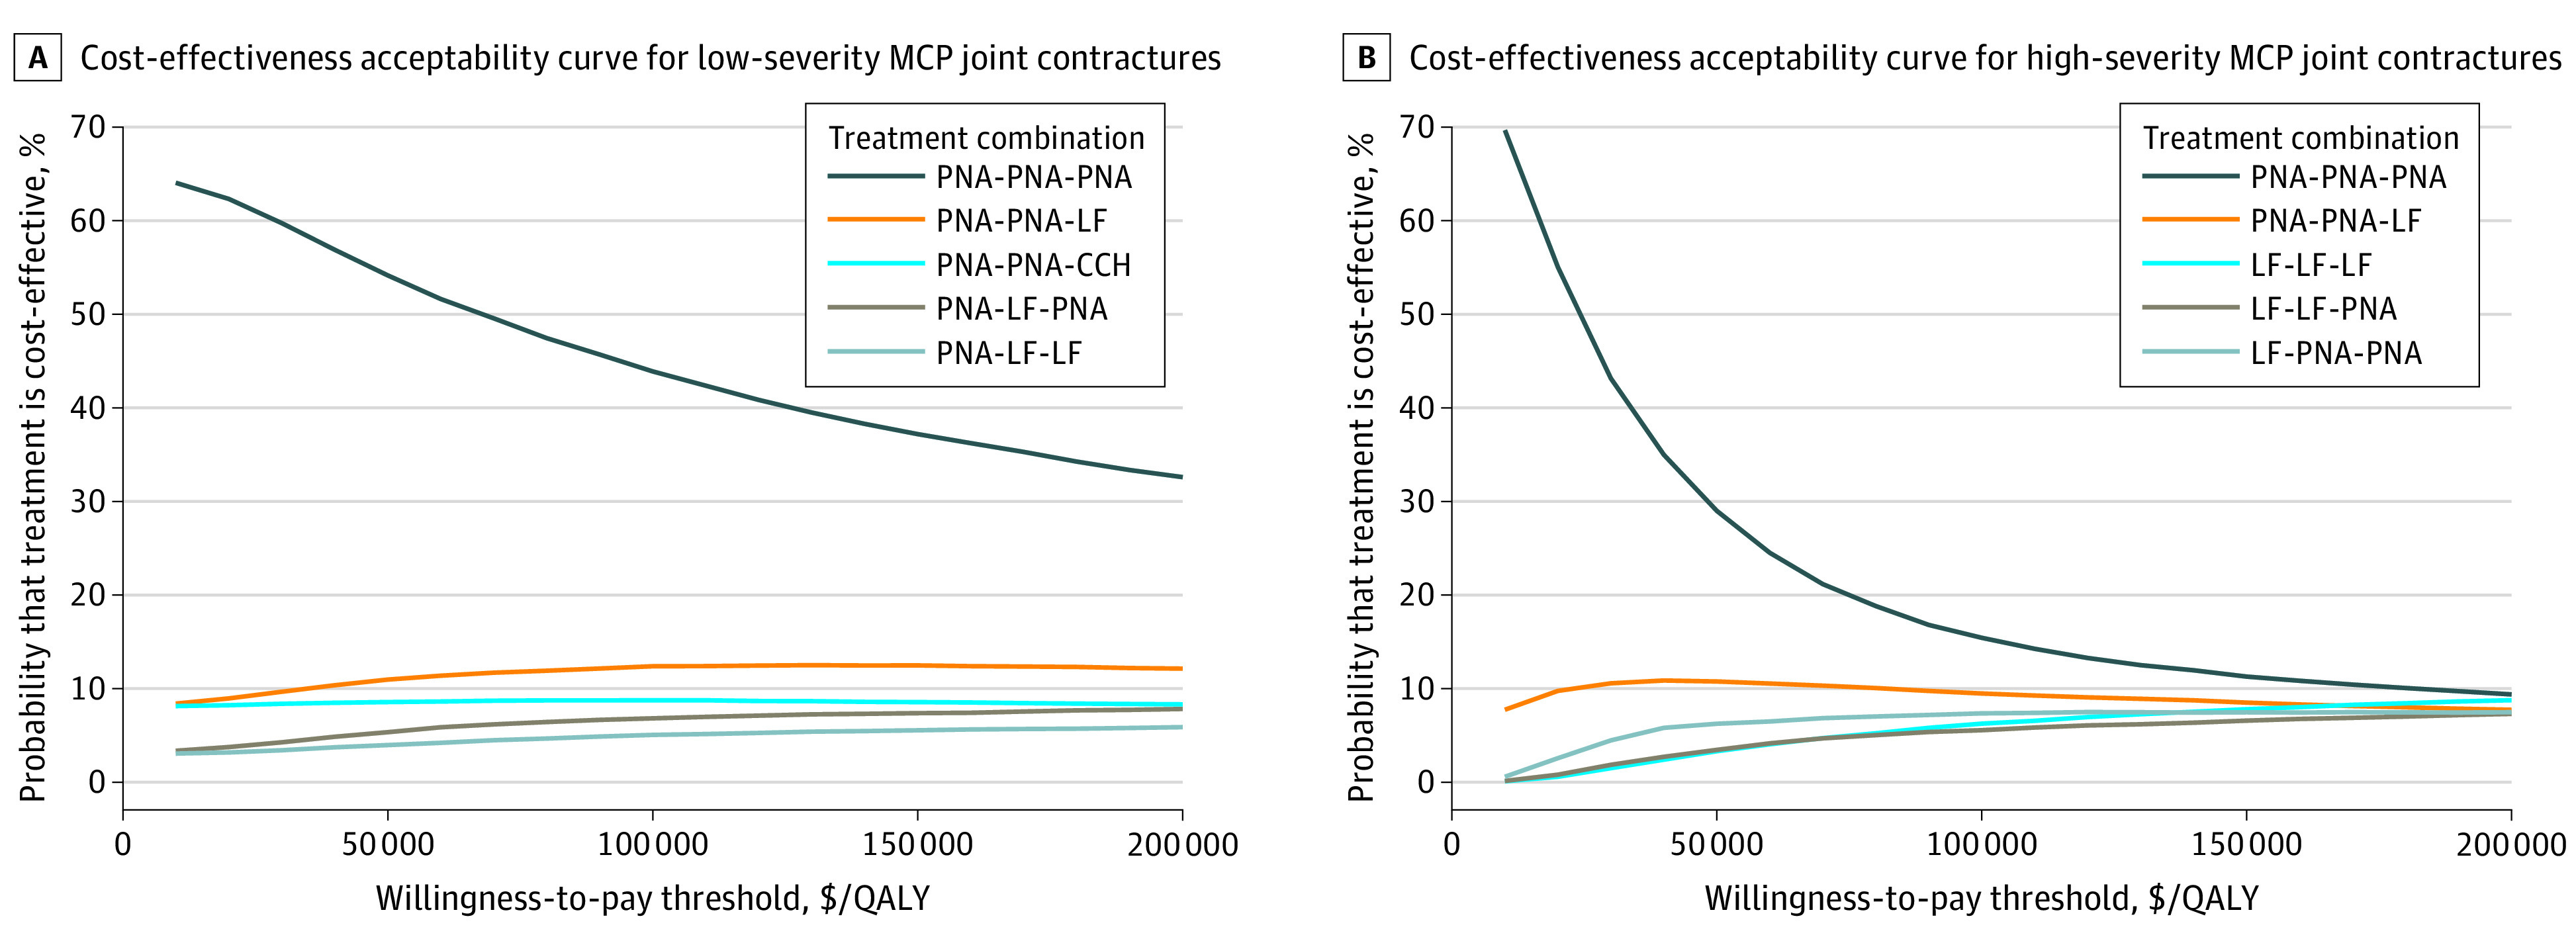
Cost-effectiveness Acceptability Curve for Metacarpophalangeal (MCP) Joint ContracturesAt a willingness-to-pay threshold of $100 000 per quality-adjusted life-year (QALY), 3 percutaneous needle aponeurotomy (PNA) treatments (PNA-PNA-PNA) had a 44% and 15% chance of being the most cost-effective treatment combination compared with the remaining 26 treatment sequences in low-severity and high-severity MCP joint contractures, respectively. CCH indicates collagenase clostridium histolyticum injection; and LF, limited fasciectomy.